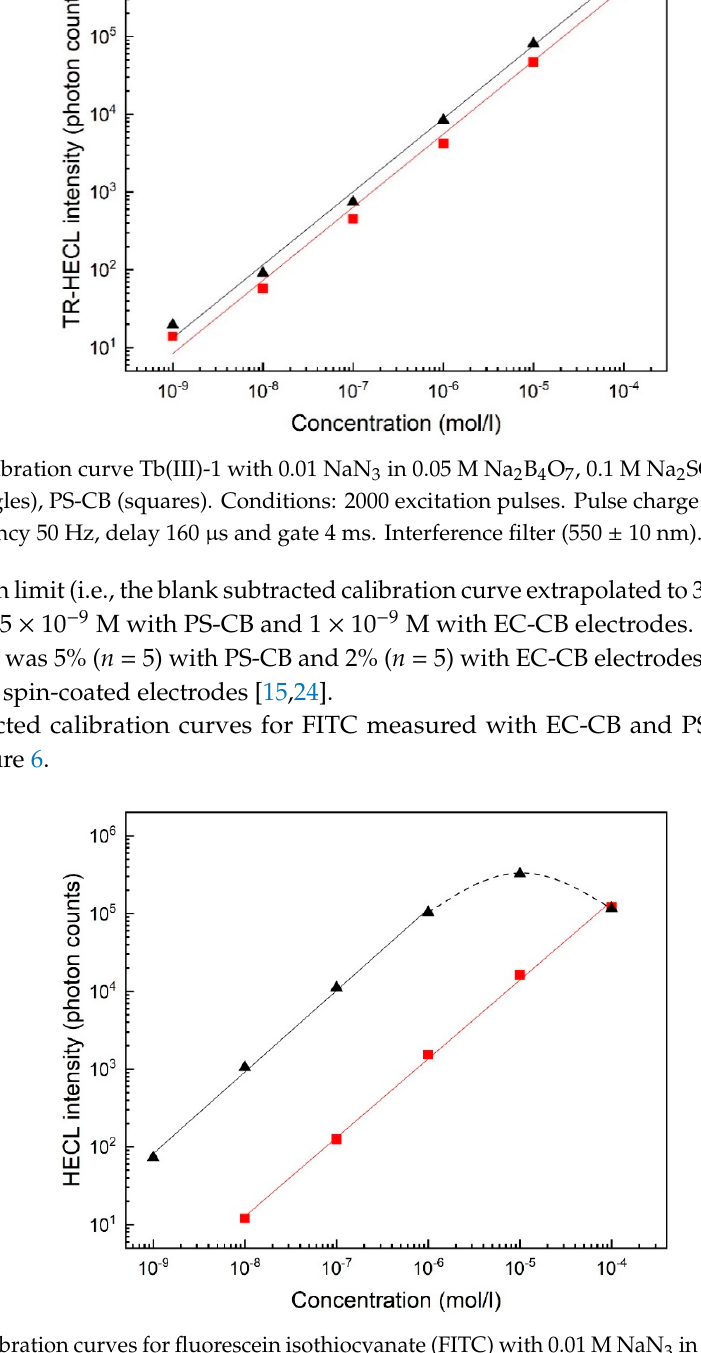
( b ) Figure 4. Long-exposure photographs, exposure time 1 s. − 46 V, 31.5 µC, frequency 50 Hz. ( a ) 3 s and ( b ) 29 s after the beginning of the excitation with 0.01 NaN 3 in 0.05 M Na 2 B 4 O 7 , 0.1 M Na 2 SO 4 . RS EC-